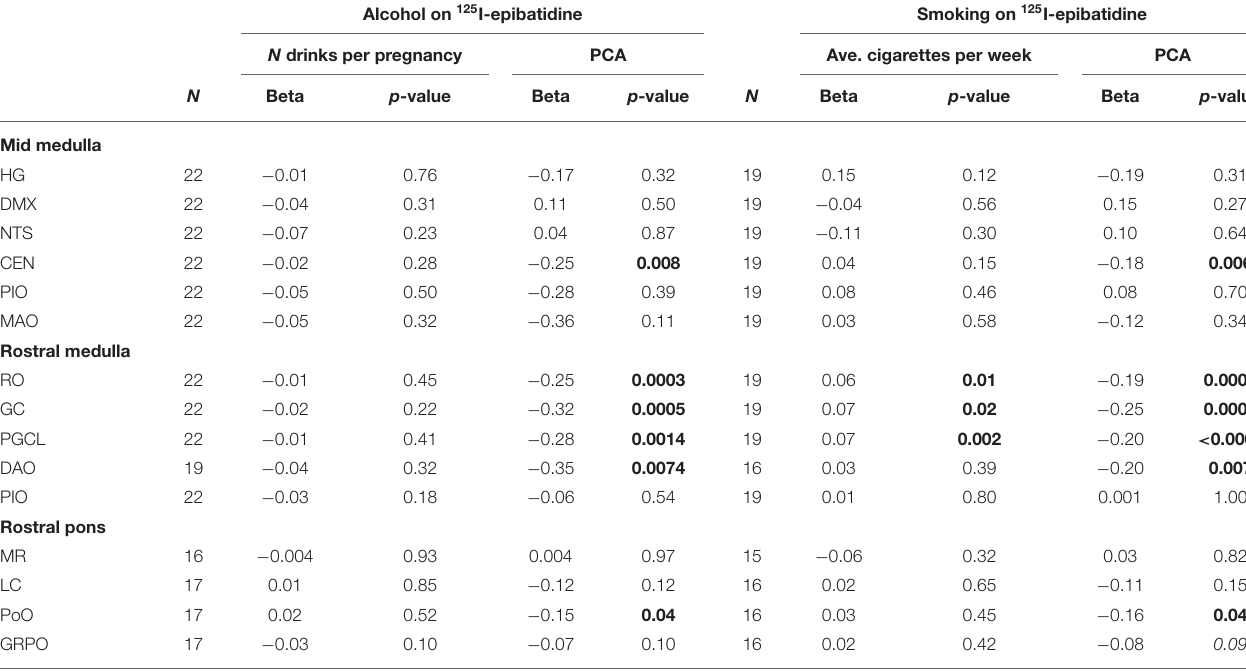
TABLE 6 | Effects of exposure on 125 I-epibatidine binding in the brainstem in SIDS and Post-KCOD controls